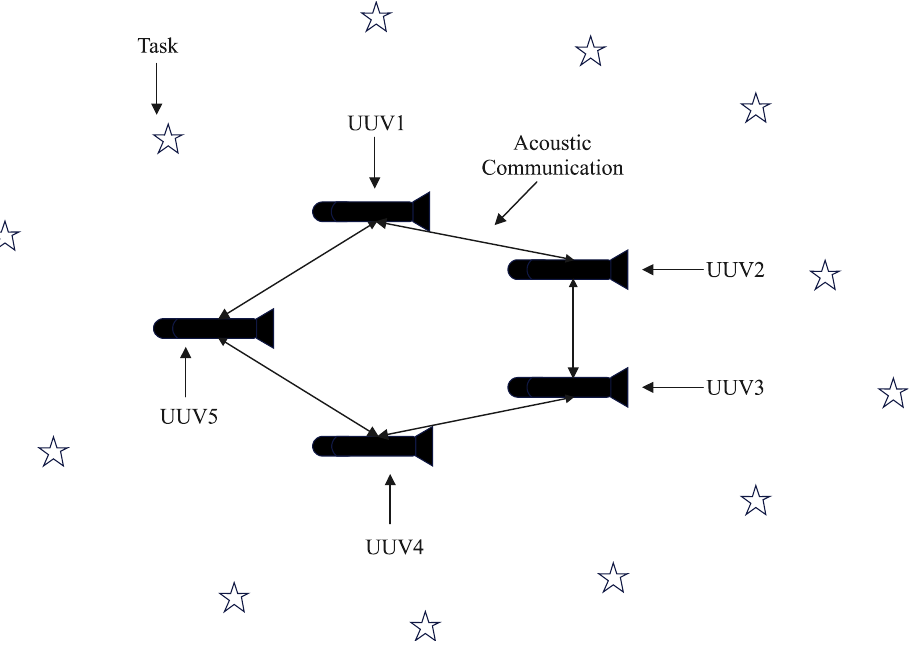
Figure 1. UUV swarm network.